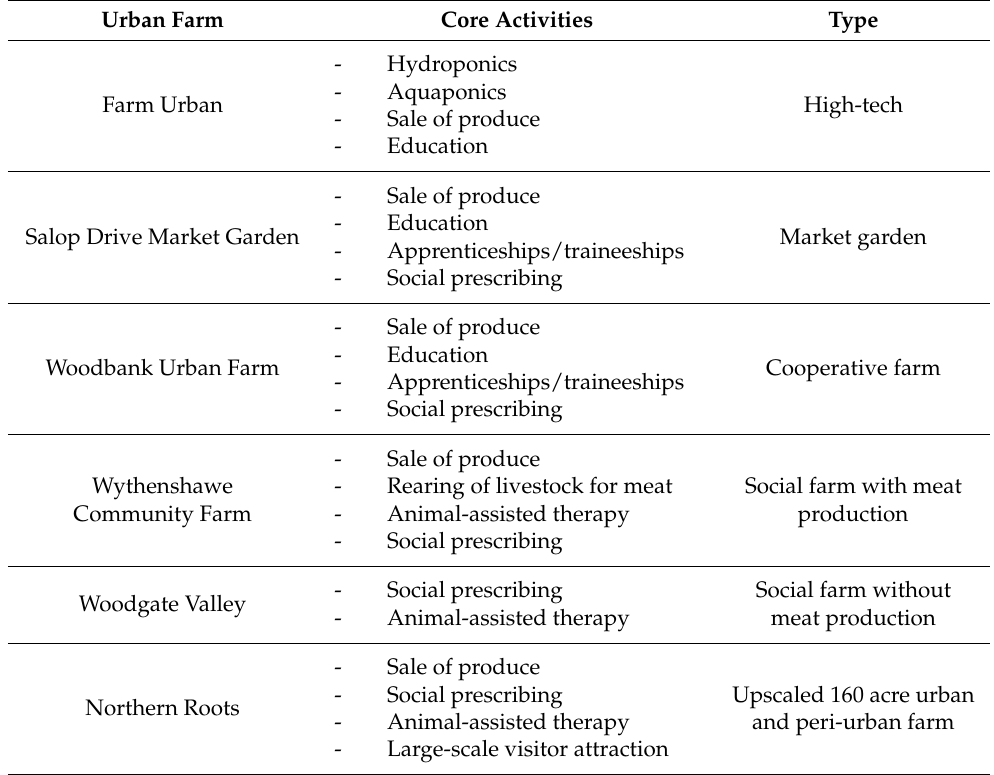
Table 1. The spectrum of urban farms